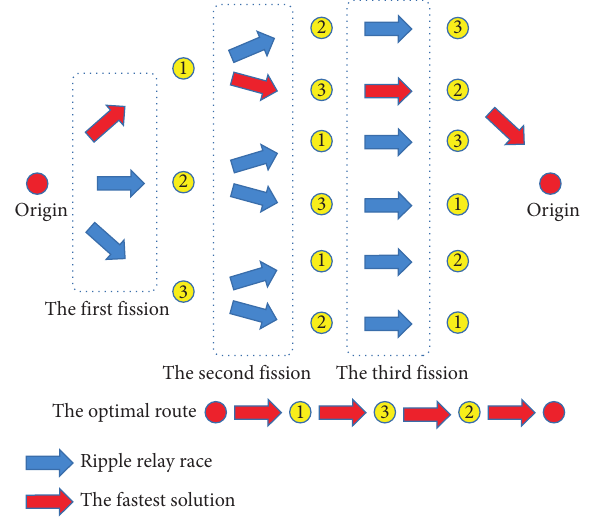
Figure 3: The schematic diagram of the fissile program in